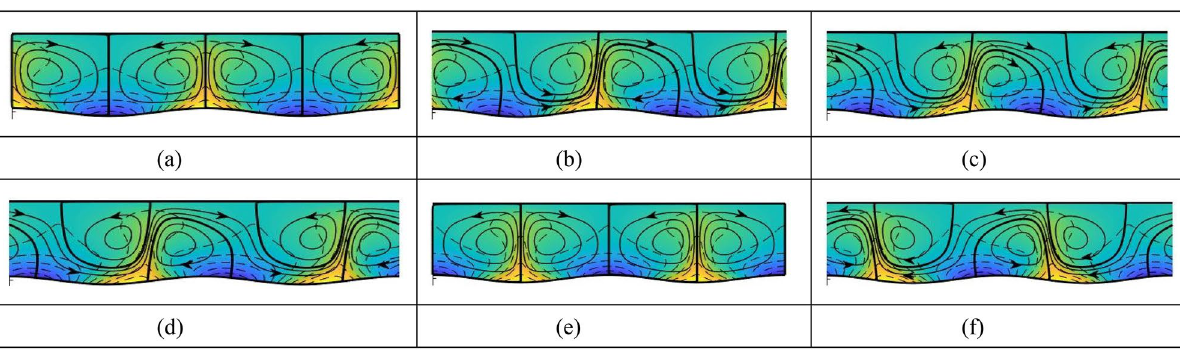
Figure 5. Flow patterns for the same geometry as in Figs. 3 and 4 for the phase difference � = 0, π/ 4, π/ 2, 3 π/ 4, π , 5 π/ 4 in ( a – f ). The lower plate temperature is expressed by a single Fourier mode with the amplitude corresponding to the periodic Rayleigh number Ra p = 1500 and the mean resulting in the uniform Rayleigh number Ra uni = 0. Colors illustrate the temperature field with equally spaced isotherms (blue corresponds to the lowest